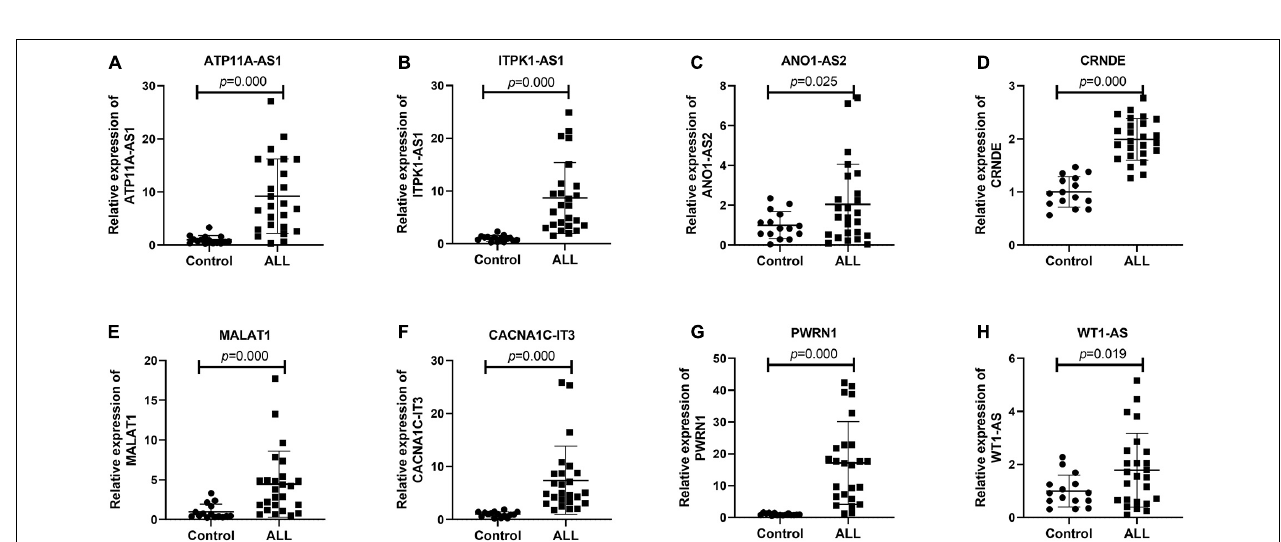
FIGURE 10 | Validation of eight lncRNAs in ALL bone marrow samples using Real-time qPCR. (A) ATP11A-AS1; (B) ITPK1-AS1; (C) ANO1-AS2; (D) CRNDE; (E) MALAT1; (F) CACNA1C-IT3; (G) PWRN1; and (H) WT1-AS. Control: n = 15; ALL: n = 25.